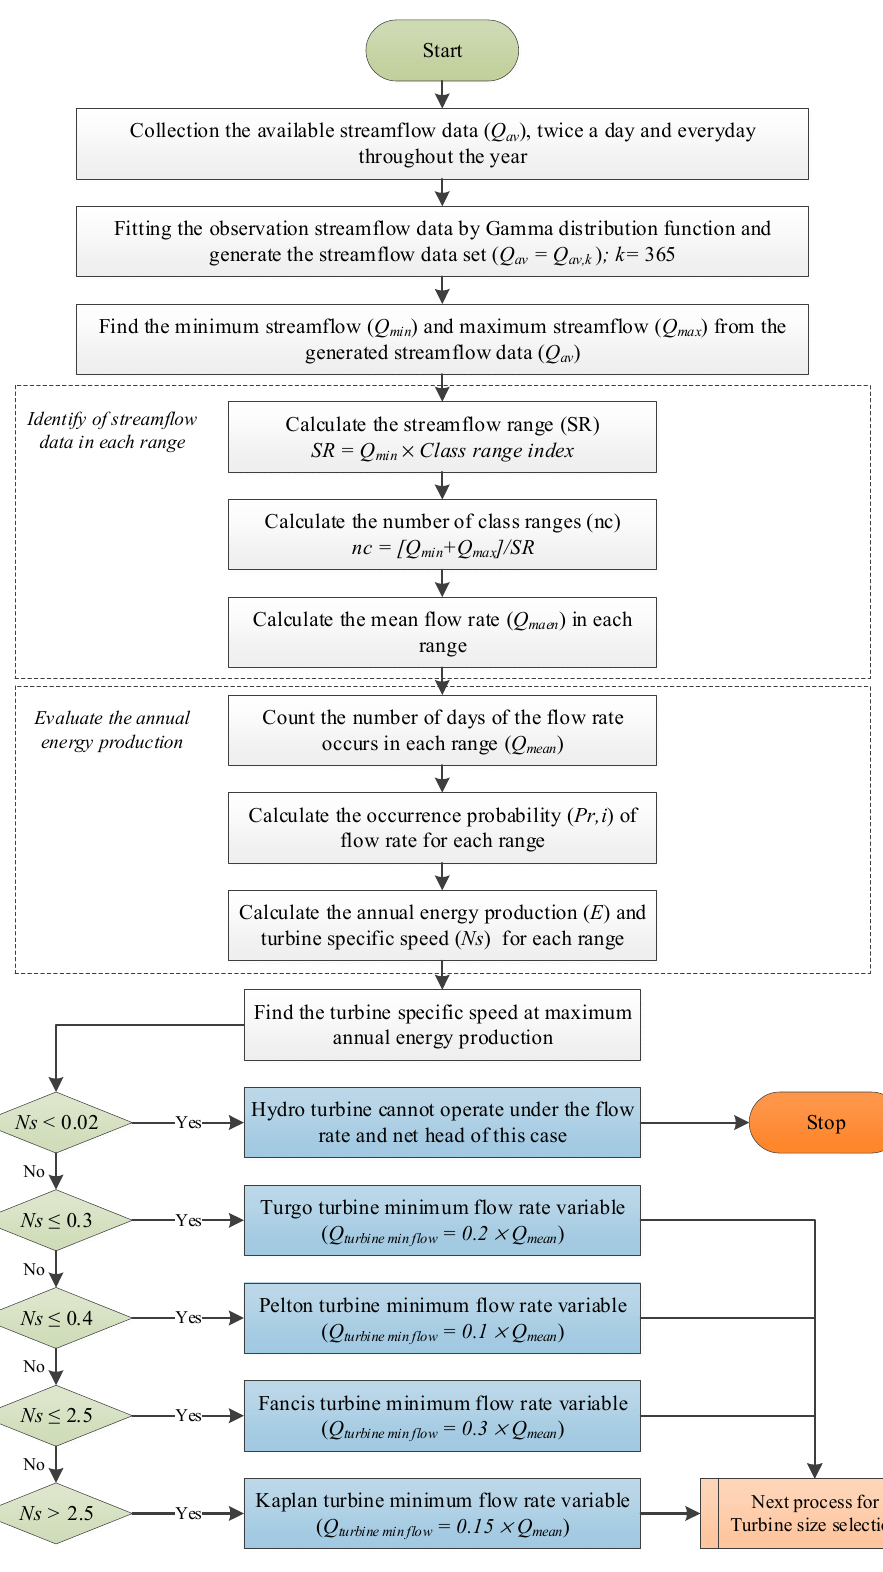
Figure 8. Optimal turbine type selection algorithm.